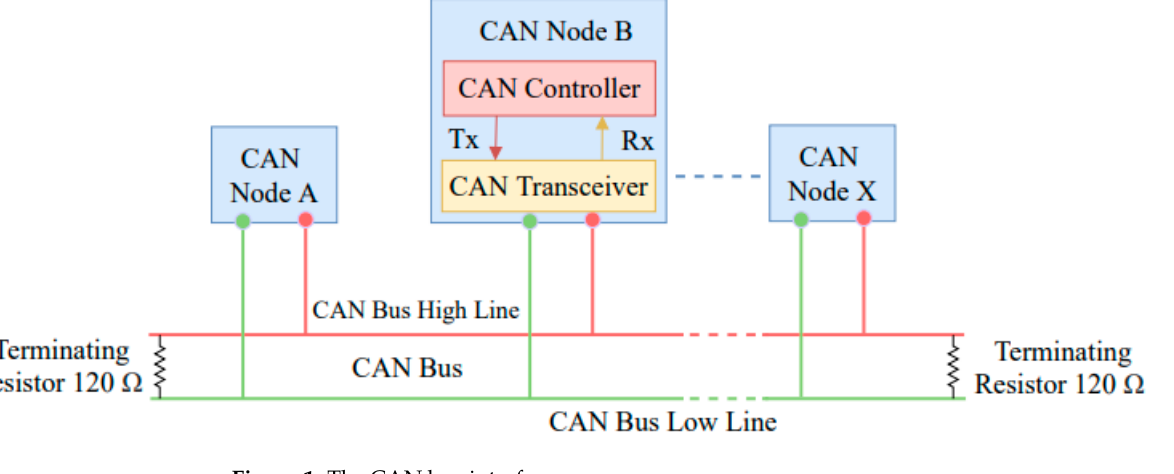
Figure 1. The CAN bus interface.